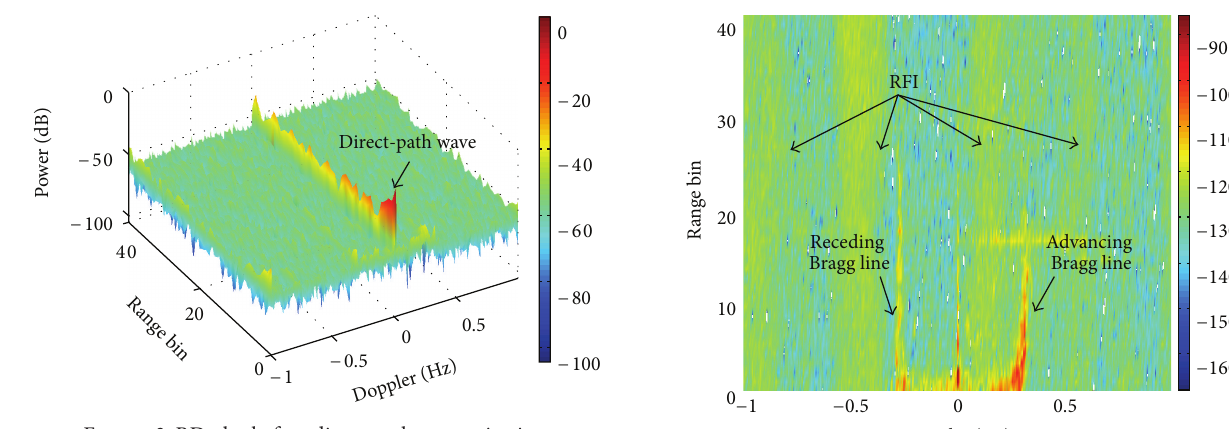
Figure 2: RD plot before direct-path wave rejection.